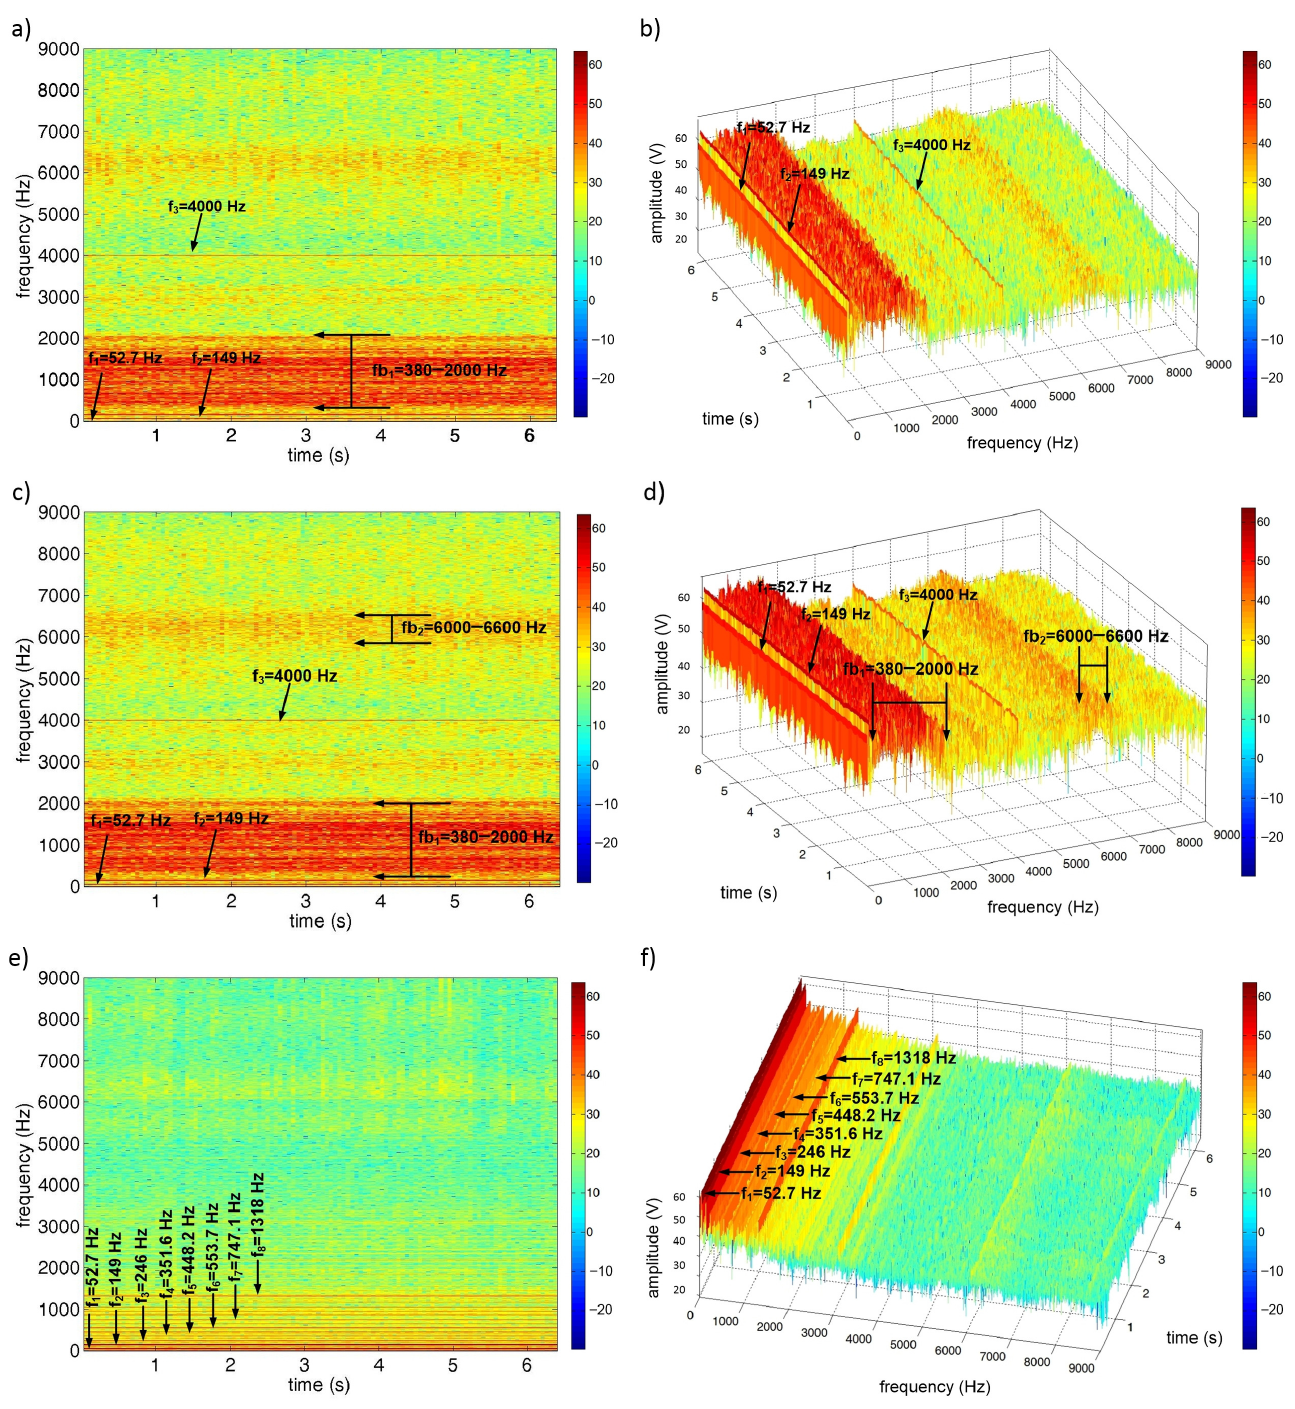
Figure 14. Spectrograms of vibration signals of acceleration (( a ) motor and pump in 2D view, ( b ) motor and pump in 3D view, ( c ) motor and hydro-generator in 2D view, ( d ) motor and hydro- generator in 3D view, ( e ) pump and hydro-generator in 2D view, ( f ) pump and hydro-generator in 3D